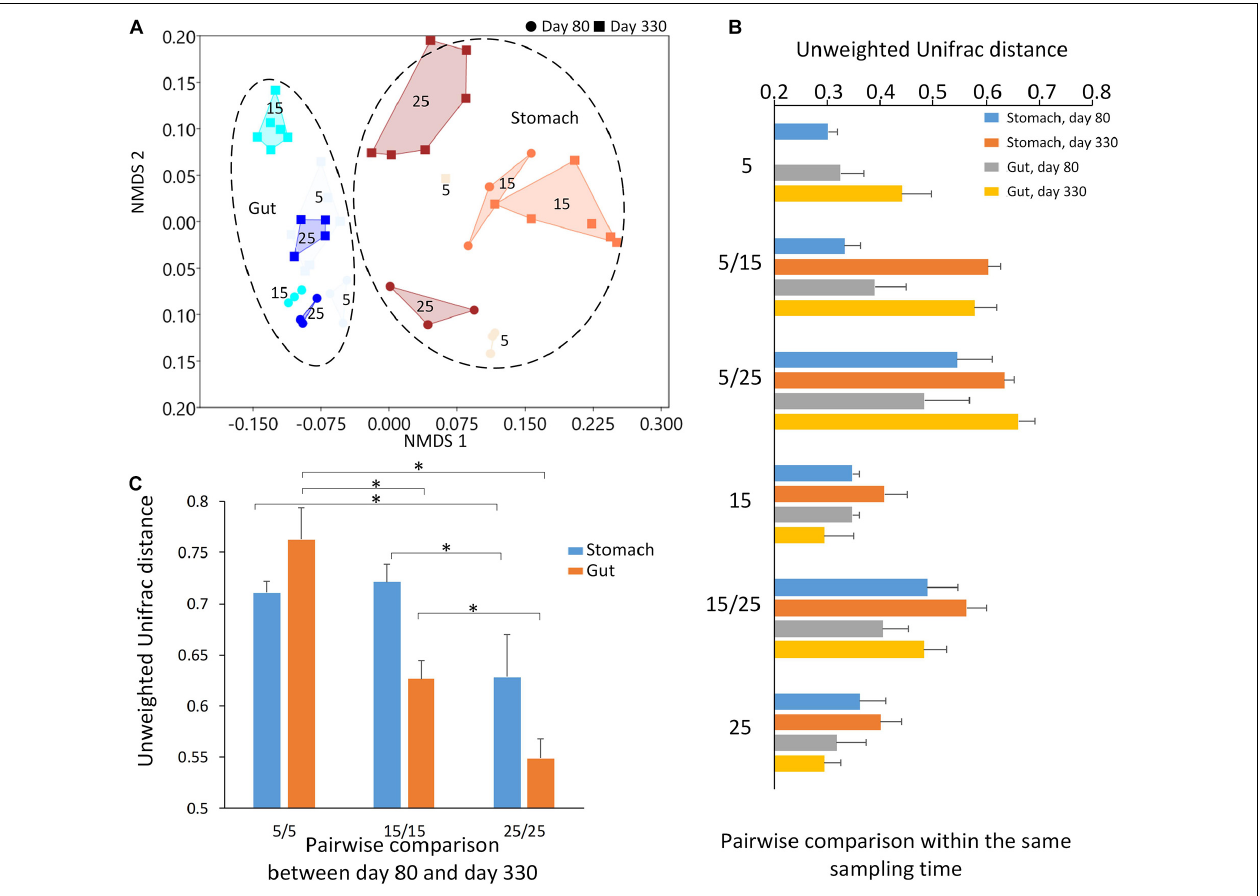
FIGURE 3 | The results of beta diversity among the groups. (A) The NMDS (non-metric multidimensional scaling) cluster analysis using Bray-Curtis distance among all samples (each spot represented one sample). The numbers in the figure represented the degree of the temperature. The closure for each group was generated by Convex Hull (Barber et al., 1996). (B) The pairwise comparisons among the groups in the stomach and gut microbiome under different temperatures within each sampling time. (C) The pairwise comparisons between the first and second sampling time in the stomach and gut microbiome under the same temperature. The one-way ANOVA test was used to test the significant differences in the pairwise comparison distance within the same sample type. If significant, the post hoc test [by Bonferroni correction: significant level at 0.05 (*)] was used to pairwise